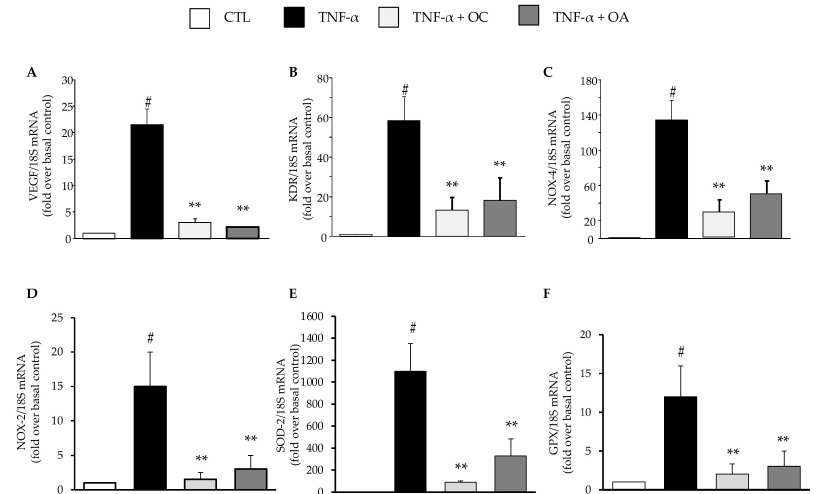
Figure 5. Modulation by OC and OA of mRNA expression levels of vascular endothelial growth factor (VEGF) and its receptor receptor kinase insert domain receptor (KDR), the pro-oxidant enzyme NADPH oxidase-4 (NOX)-4 and NOX-2, and the antioxidant enzymes superoxide dismutase (SOD)-2 and glutathione peroxidase (GPX). SGBS adipocytes were pretreated with OC or OA 25 µ mol / L (6 h) and then treated with 10 ng / mL TNF- α for 18 h. Total RNA was extracted from cells, and mRNA levels of VEGF ( A ), KDR ( B ), NOX-4 ( C ), NOX-2 ( D ), SOD-2 ( E ) and GPX ( F ) were measured by qPCR using specific primers and probes and normalized to 18S RNA. Data (means ± SD, n = 3) are expressed as fold induction over unstimulated control (CTL). # p < 0.05 versus CTL. ** p < 0.01 versus TNF- α